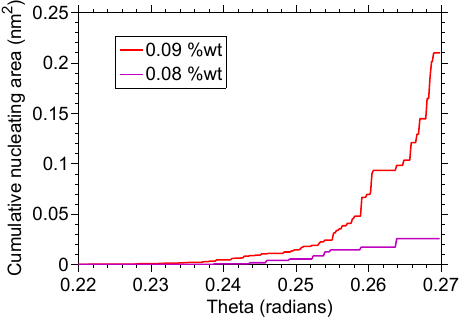
Figure 10. Cumulative ice nucleating surface areas from applica- tion of Eq. (11) to modeled average g distributions from droplets containing 0.09wt% Snomax (red) and 0.08wt% Snomax (purple) in Fig. 6 plotted against the critical contact angle range. This system does not exhibit similar nucleating areas at low contact angles and thus does not show an increase in n s with decreasing concentration (or surface